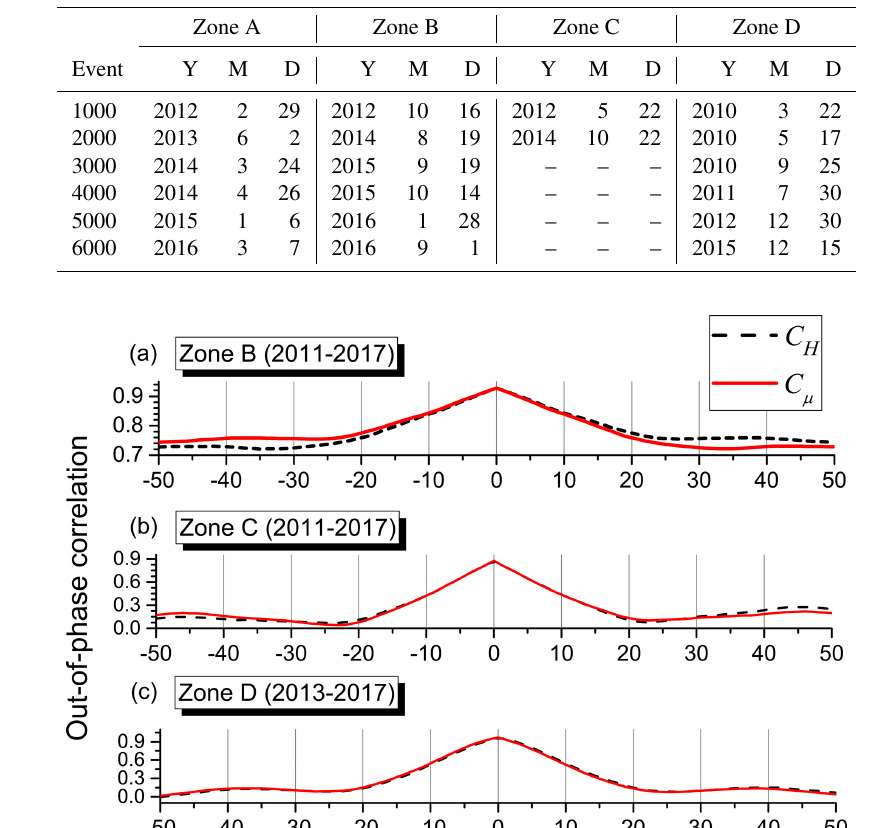
Table 2. Equivalence of the milestones for natural time in thousands of events in terms of real date: year (Y), month (M) and day (D) for Figs. 3–6.